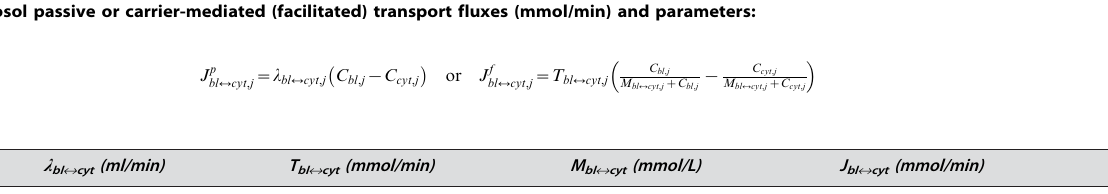
Table 3. Optimal model parameter values for the inter-domain transport fluxes determined from the steady-state parameter estimation